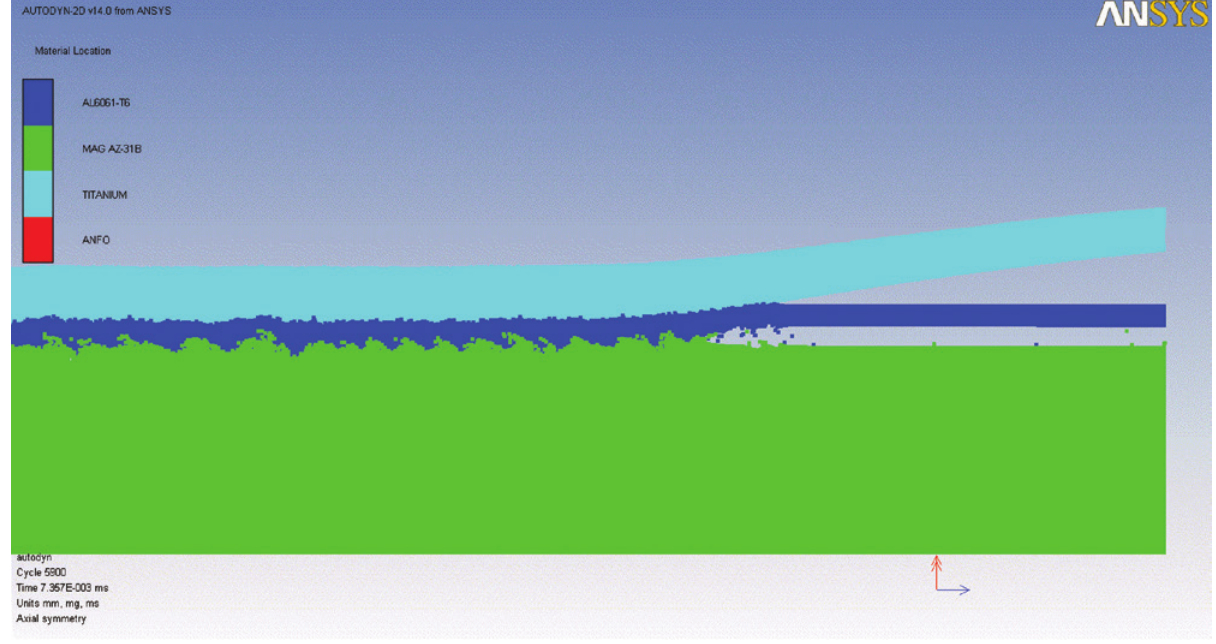
Figure 4: The material location of combination in the